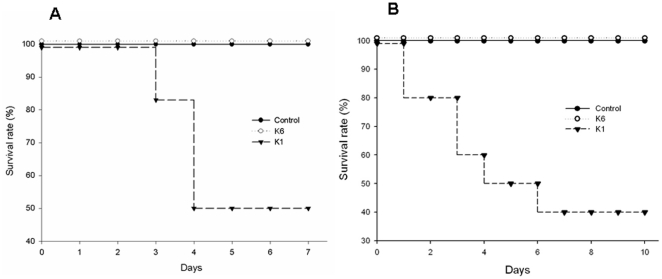
Survival rate of BALB/c mice (n = 12 per group) following intraperitoneal injection of neutrophils containing phagocytosed serotypes K1 and K6 K. pneumoniae.The number of viable intracellular bacteria were 4×103 and 5×105 for serotypes K1 and K6. Survival was observed for 10 days. Each experiment was repeated twice. (A) Human neutrophils. (B) BALB/c neutrophils. (p<0.001, for the serotype K1 group vs. the K6 and control groups in human and mouse experiments.)